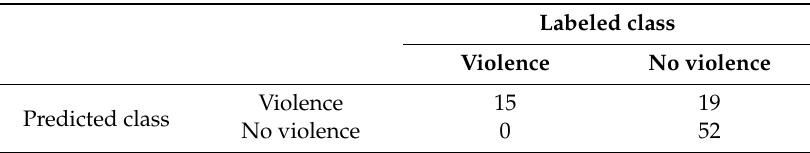
Table 1. Confusion matrix for the best recall